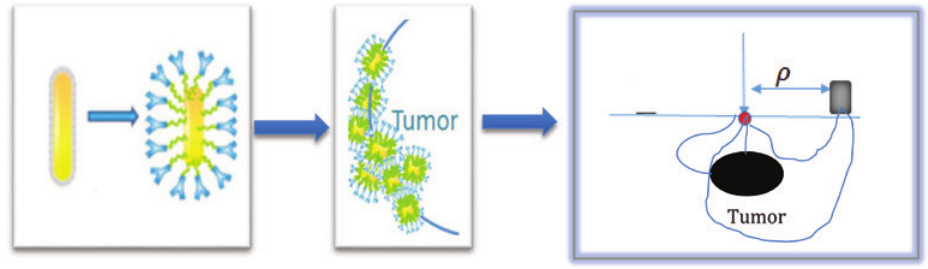
Figure 2: Illustration of the GNRs bio-molecular mechanism for DR tumor detection measurements. The targeted GNRs accumulate in the tumor site and enhance its absorption coefficient. In the DR measurements, this accumulation is pre- sented as a dark site within the tissue, which absorbs radiance and decreases reflected light